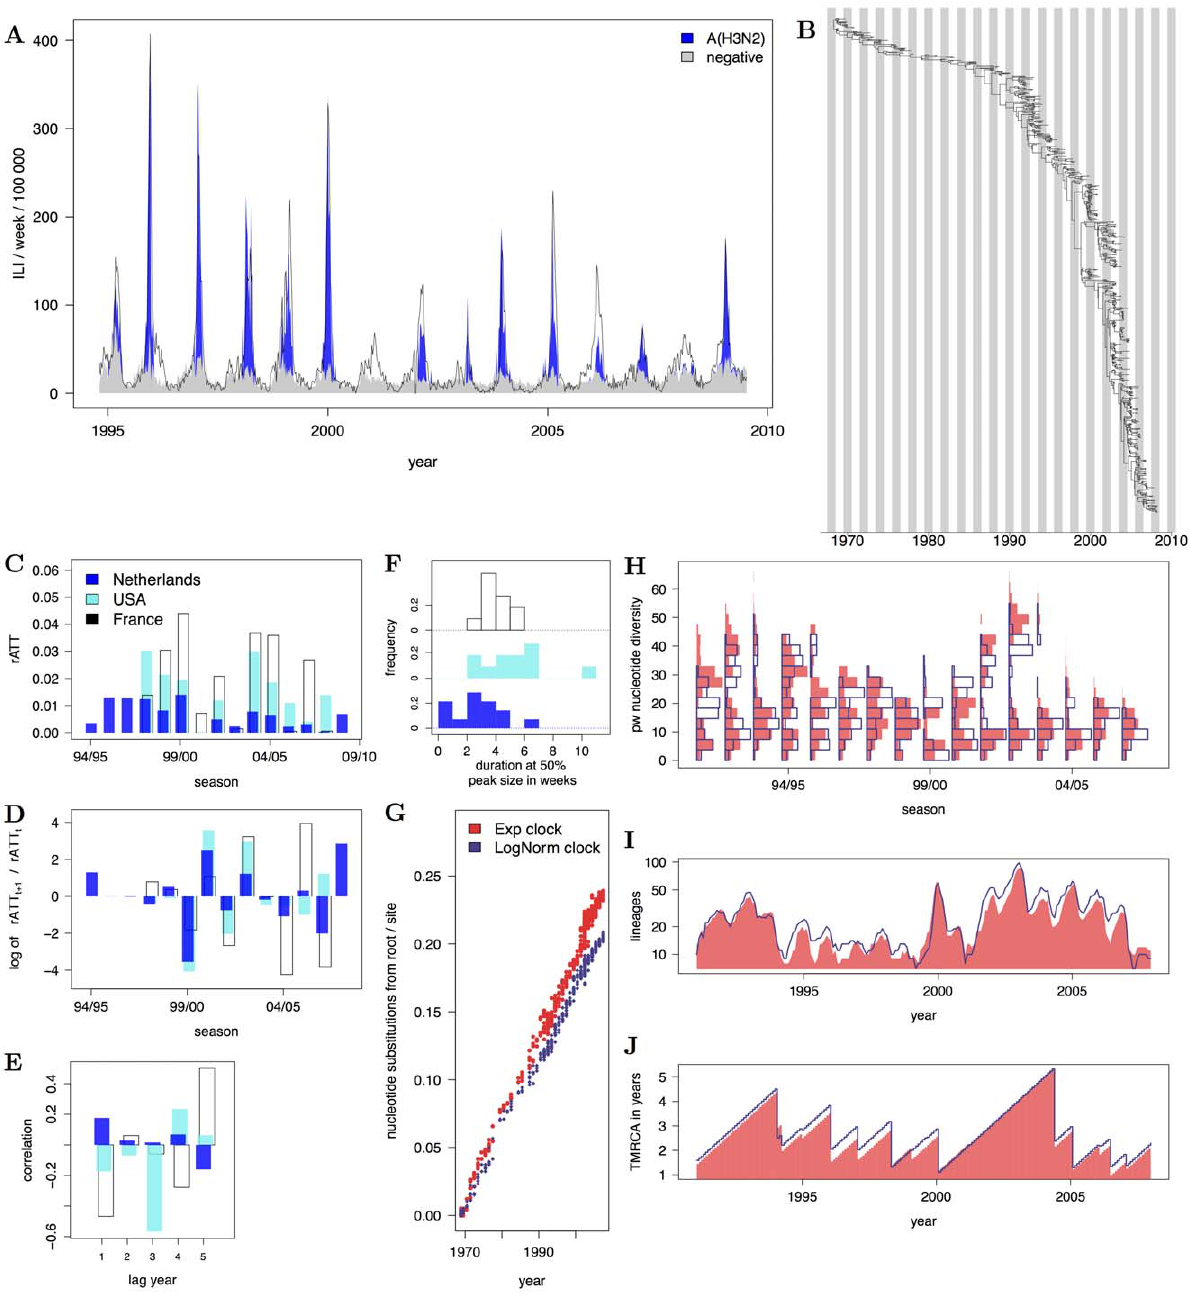
Figure 1. Features of H3N2 sequence and incidence data. (A) Weekly ILI time series from the Netherlands, and estimated time series of influenza A(H3N2) from weekly virological data. Type and subtype specific time series were estimated under an additive Negative Binomial regression model; see Text S1. (B) Reconstructed HA phylogeny from 776 European sequences with known times of isolation. The phylogeny was inferred with the BEAST program under a relaxed Exponential clock; see Text S1. (C) H3N2 seasonal attack rates (rATT), calculated from estimated H3N2 case report times series in the Netherlands in 1994–2009 (blue), and the USA (cyan) as well as France in 1997–2008 (black). (D) Ratio of consecutive case report attack rates on the log scale. (E) Autocorrelation of case report peaks. (F) Histogram of the duration of seasonal epidemics at half their peak size. (G) Number of estimated nucleotide substitutions of dated HA sequences from the root A/Bilthoven/16190/68 as in Smith et al. [31]. Nucleotide substitutions were estimated with BEAST under an Exponential clock (red) and Lognormal clock model (violet). (H) Histograms of pairwise nucleotide diversity among sequences collected in the same season. (I) Time series of the number of phylogenetic lineages circulating within the same month. (J) Time series of the time to the most recent common ancestor of phylogenetic lineages circulating within the same month. Colors from H to J are as in G.